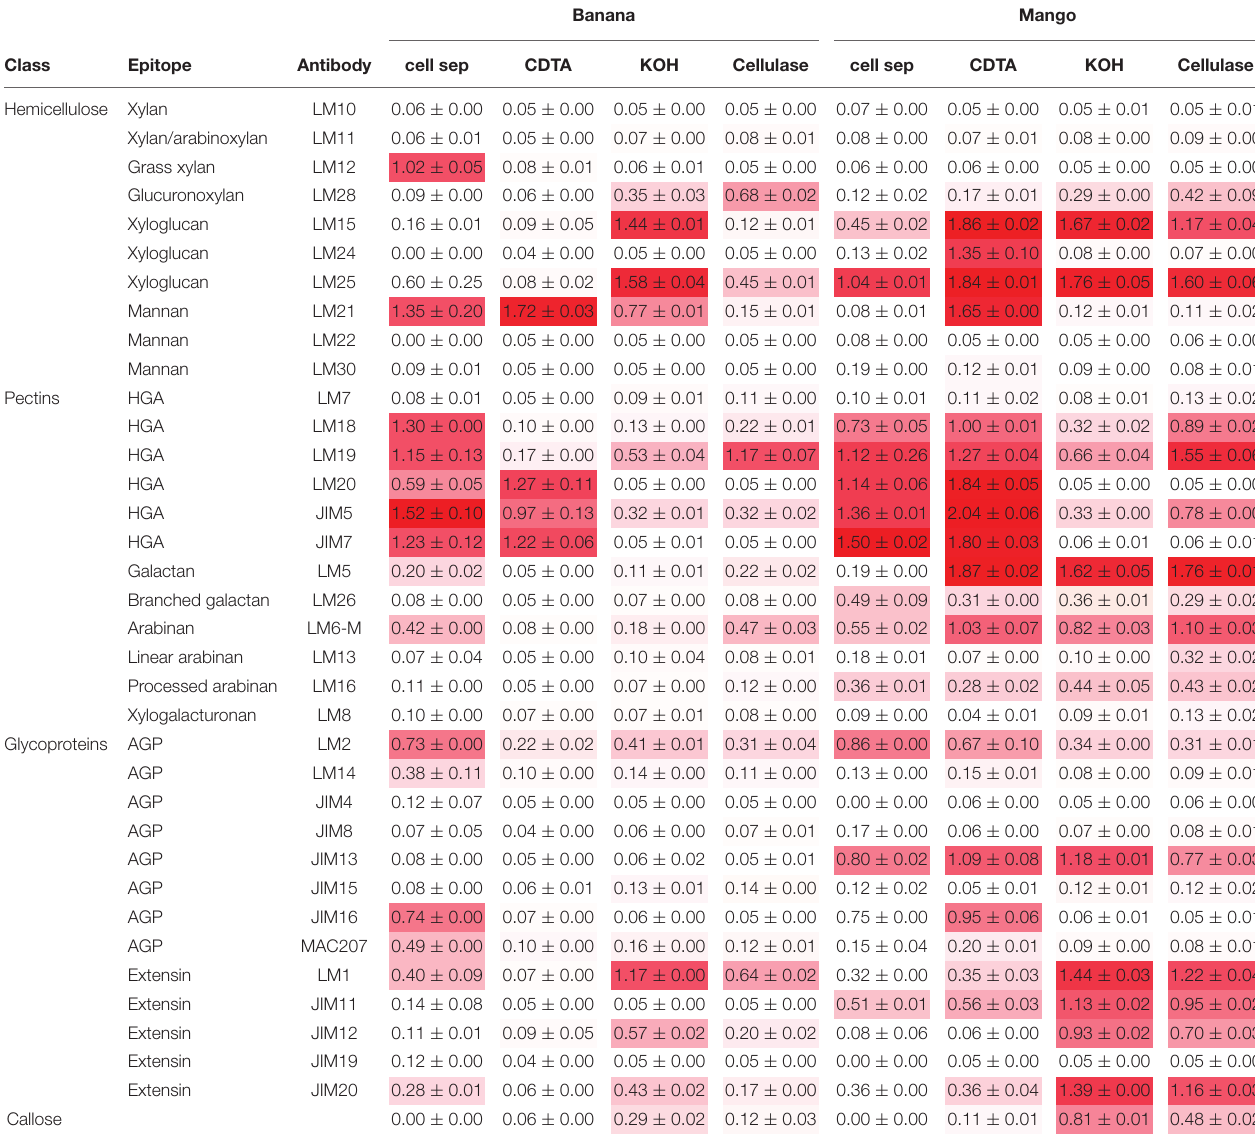
TABLE 1 | Cell wall glycome profiling of cell separation supernatants and fractions extracted from banana and mango AIR represented in heat map. Banana Mango Antibody cell sep CDTA KOH Cellulase cell sep CDTA KOH